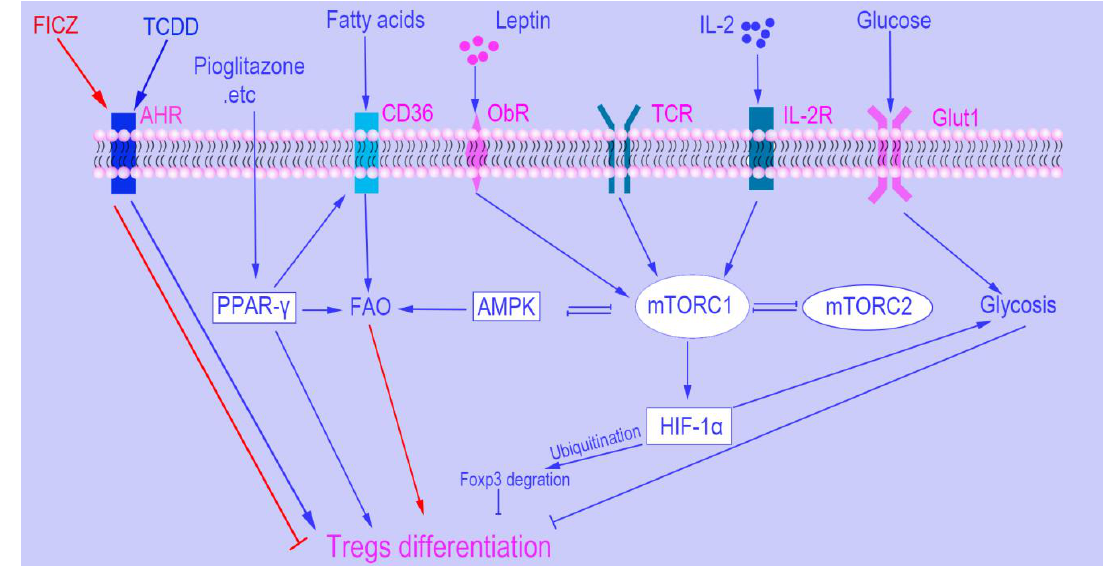
Figure 3. Metabolic and mTOR signaling control of Regulatory T cells’ differentiation. Different ligand binding with aryl hydrocarbon receptor (AHR) leads to dissimilar outcome in Tregs induction. For example, 6-formylindolo [3,2-b] carbazole (FICZ) binding with AHR inhibits Tregs generation while 2,3,7,8-tetrachlorodibenzo- p -dioxin (TCDD) promotes Tregs generation. Peroxisome proliferator-activated receptor- γ (PPAR- γ ) increase Tregs differentiation via regulating the balance between fatty-acid oxidation (FAO) and glycometabolism. AMP-activated protein kinase (AMPK) is an important metabolic checkpoint in Tregs differentiation, and there is controversy regarding the role of the AMPK in Tregs differentiation. mTOR signaling is the most important metabolic regulator of